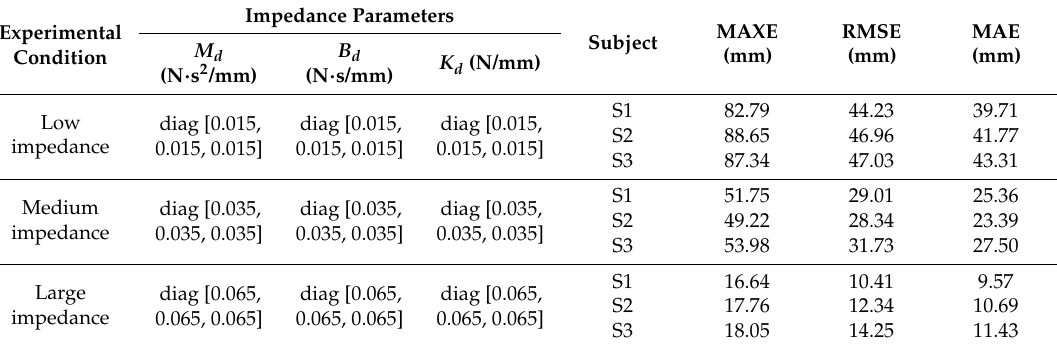
Table 4. The results of trajectory tracking experiments with impedance adjustment under different experimental conditions (i.e., different impedance